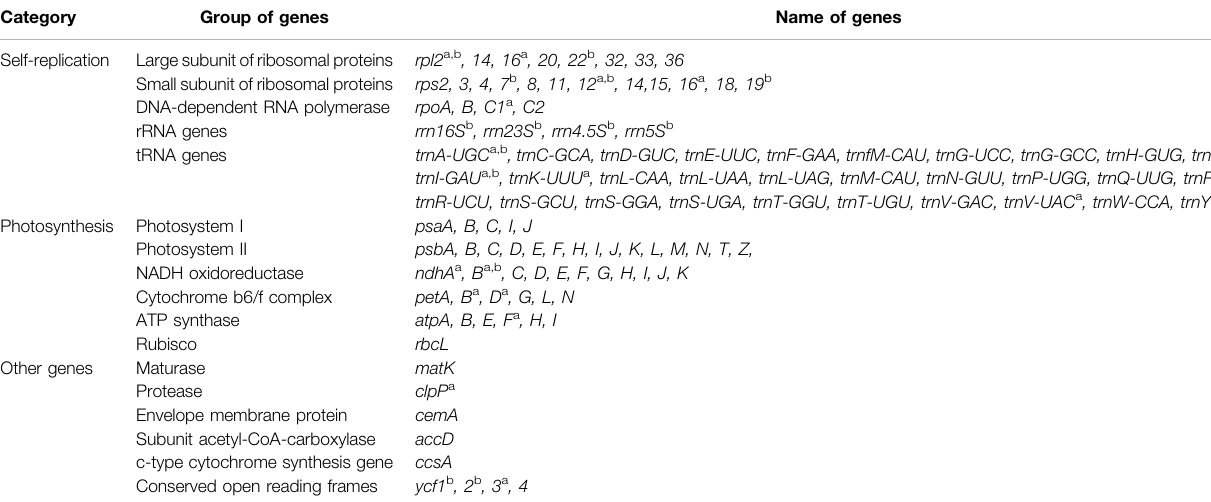
TABLE 2 | Gene composition of the chloroplast genome of Polygonum .